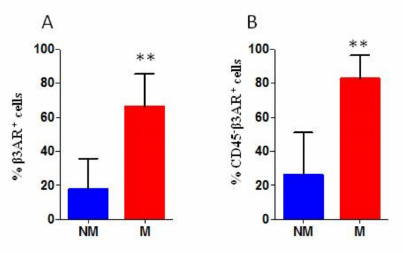
Figure 4. Cytofluorimetric analysis of bone marrow derived cells, the percentage of positive cells is reported. ( A ) percentage of β 3-AR positive cells within all BM cells (% β 3-AR + cells range: NM 2.5–48%; M 46–85%) and ( B ) percentage of β 3-AR positive cells within CD45 − gated BM cells (% β 3-AR + cells range: NM 0.5–56%; M 65–91%). BM from 14 patients: 5 M and 9 NM. P values for analysis: ** p < 0.01.